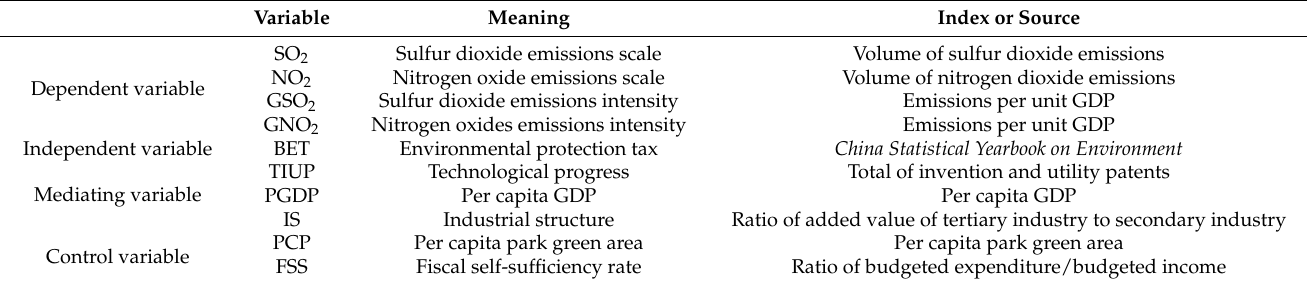
Table 1. Definitions and descriptions of variables.